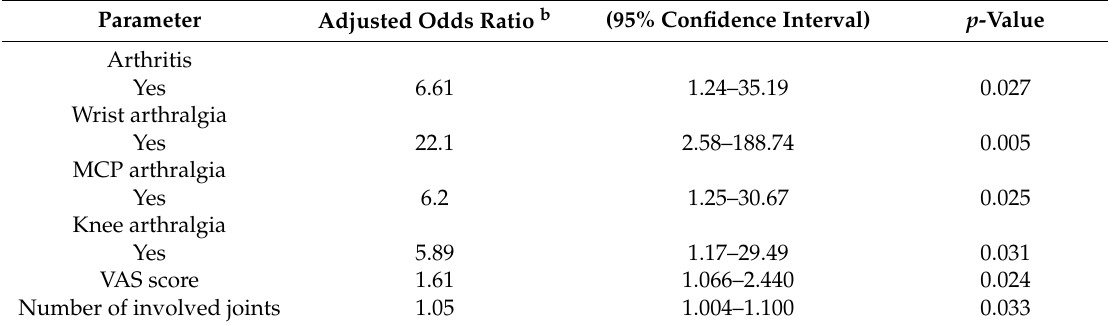
Table 3. Multivariate analysis associated with Chikungunya fever in southeastern Mexican population a . Parameter Adjusted Odds Ratio b (95% Confidence Interval) p